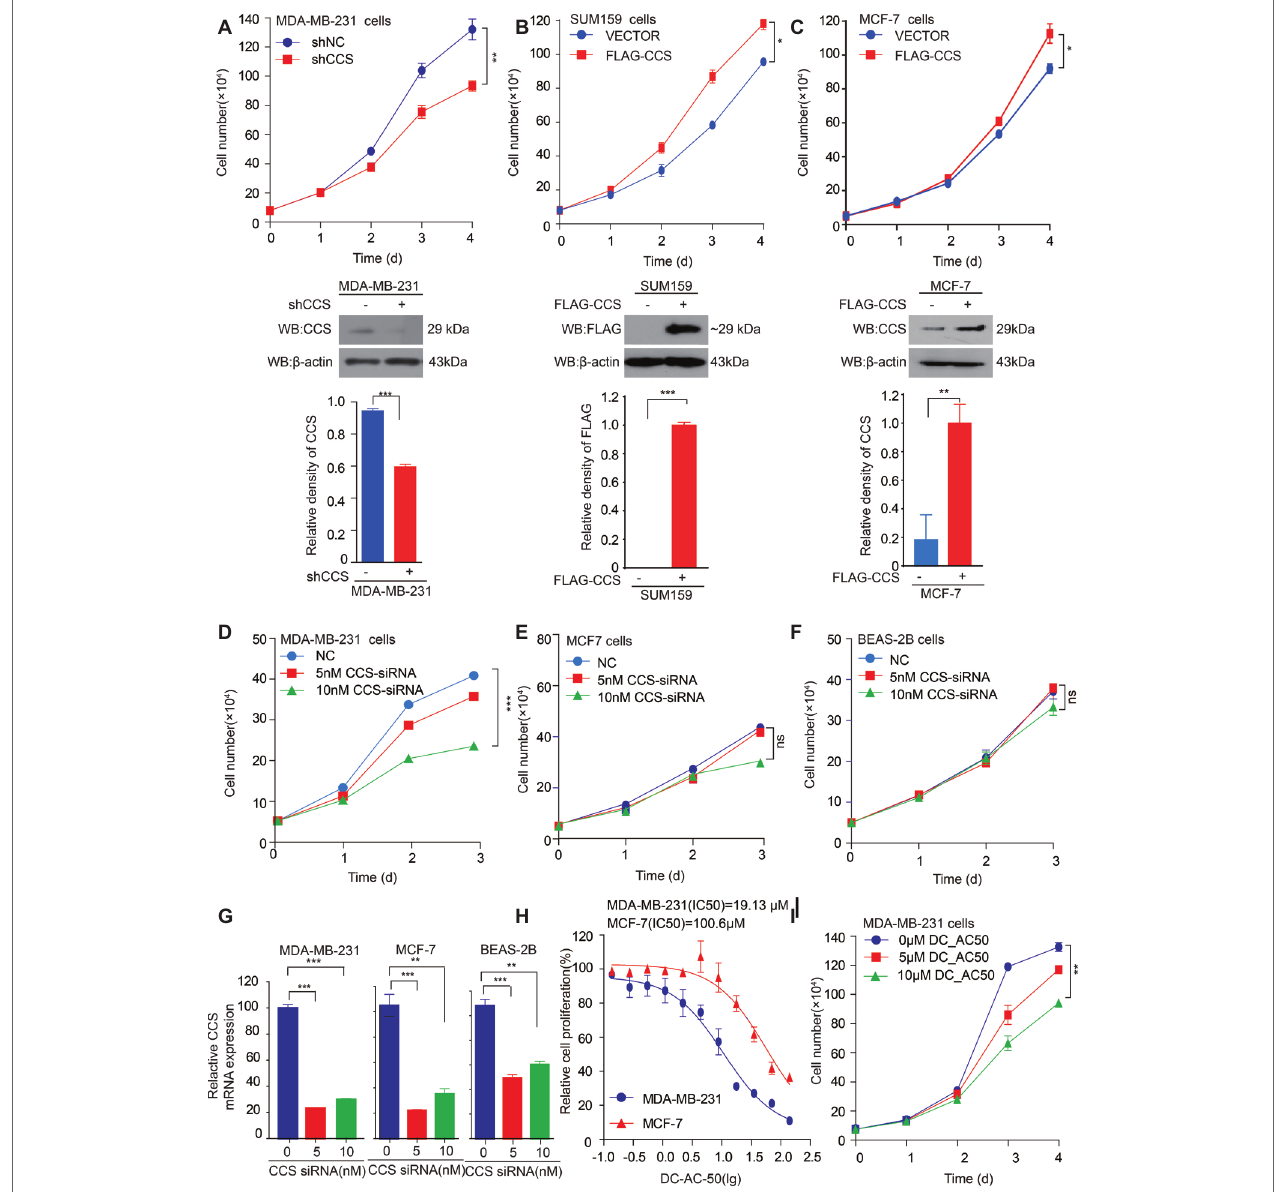
FIGURE 2 | CCS promotes breast cancer cell proliferation. (A) Cell proliferation was determined by cell number counting assays in CCS stable knockdown MDA-MB-231 cells, and the knockdown efficiency was determined by western blotting. (B) Cell proliferation was determined by cell number counting assays in CCS overexpressing SUM159 cells, and CCS expression was determined by western blotting. (C) Cell proliferation was determined by cell number counting assays in CCS overexpressing MCF-7 cells, and CCS expression was determined by western blotting. (D–F) Cell proliferation was determined by cell number counting assays in MDA-MB-231 cells (D) , MCF-7 cells (E) , and normal human BEAS-2B cells (F) , which were transiently transfected with increasing concentrations of CCS siRNA and control siRNA. (G) The relative CCS mRNA level was determined by q-PCR in MDA-MB-231, MCF-7and BEAS-2B cells, which were transiently transfected with increasing concentrations of CCS siRNA and control siRNA. (H) The sensitivities of MDA-MB-231 and MCF-7 cells to DC_AC50 were determined by cell number counting assays when the cells were treated with increasing concentrations of DC_AC50 for 48 h. (I) Cell proliferation was determined by cell count assays in MDA-MB-231 cells treated with increasing concentrations of DC_AC50. All results performed above are presented as mean ± SD from three independent experiments. * p < 0.05; ** p < 0.01; *** p < 0.001, ns: not